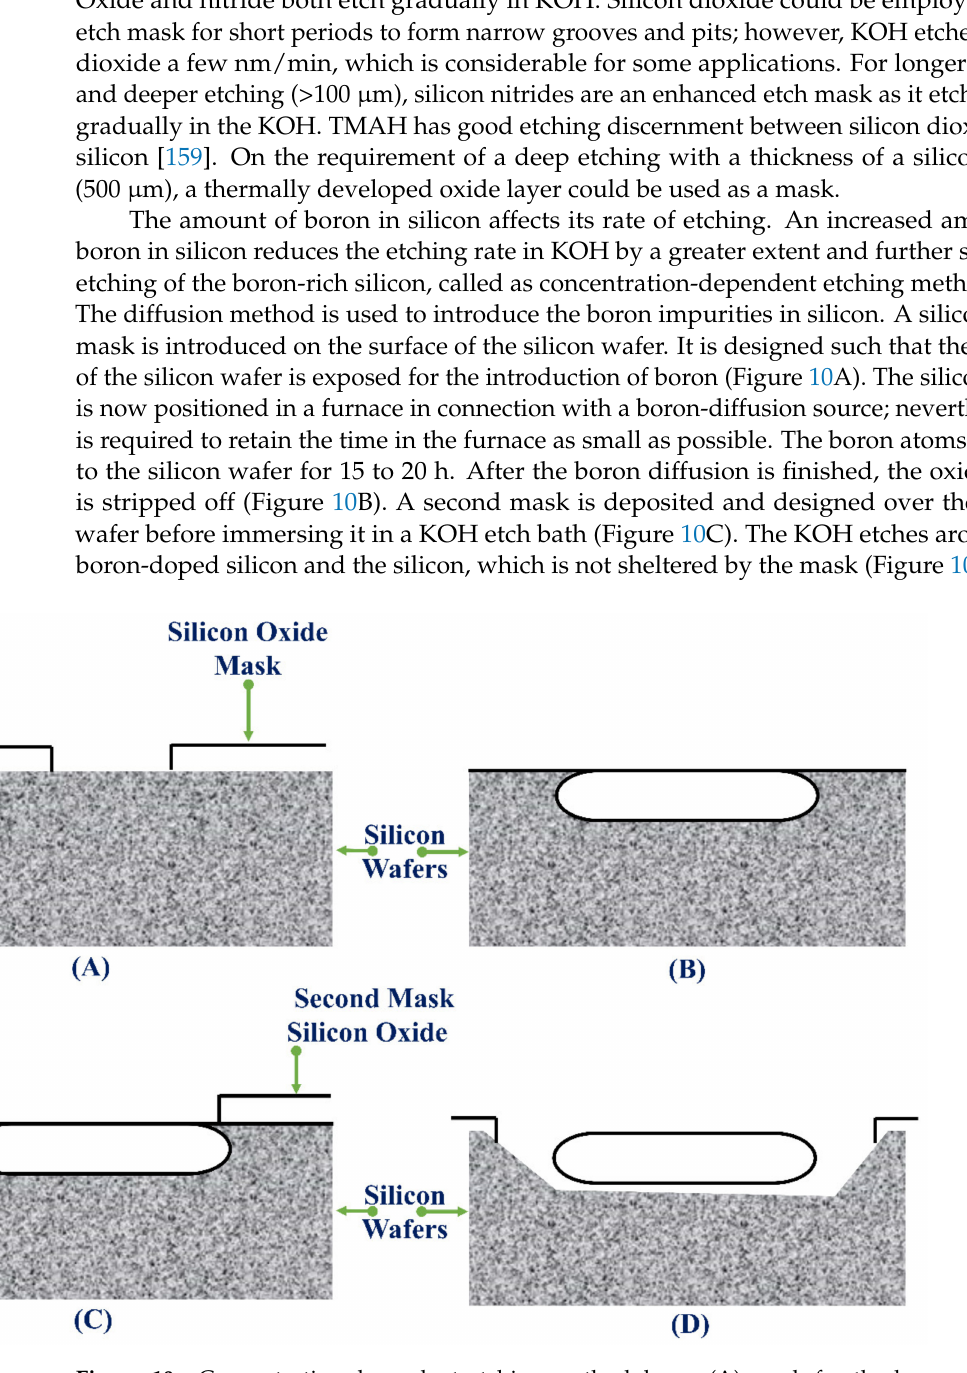
Figure 10. Concentration-dependent etching methodology: ( A ) mask for the boron diffusion, ( B ) oxide mask stripped succeeding diffusion, ( C ) mask for the KOH etching, ( D ) boron-doped structure expelled by the KOH etching [120]. (Reprinted from Ref.